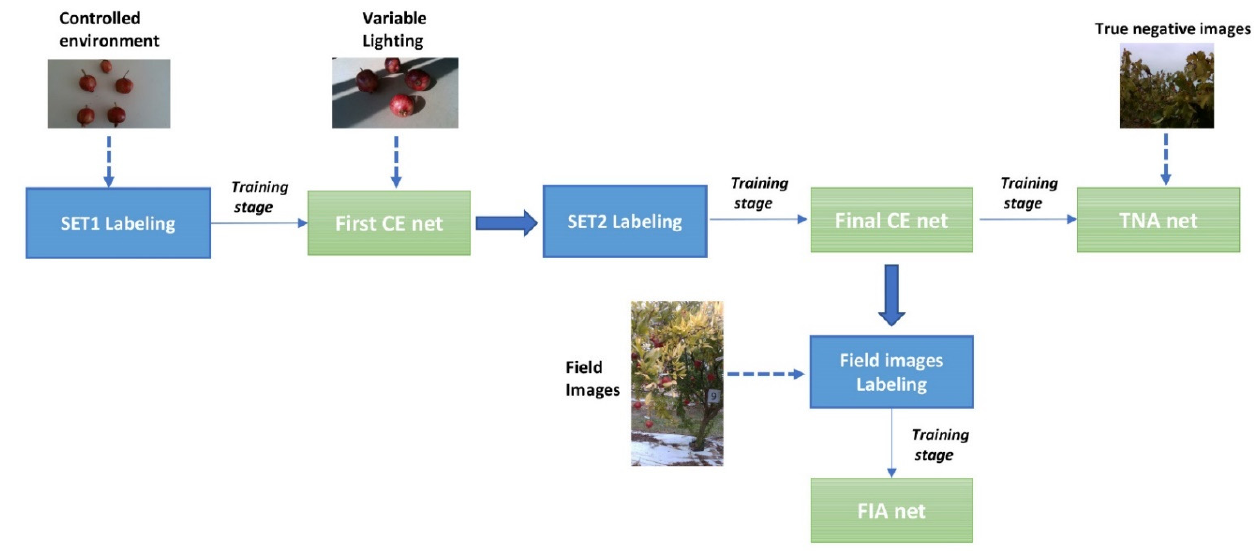
Figure 3. Pipeline of the image segmentation approach .